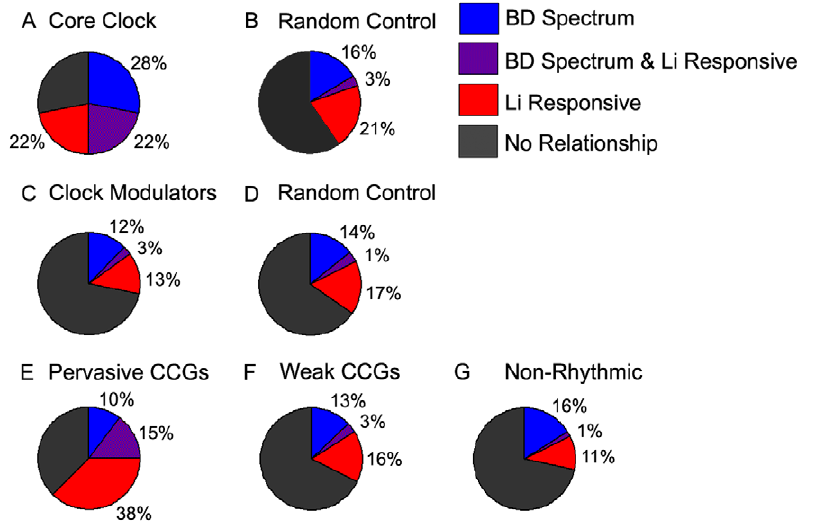
Figure 3. Overlap among clock genes, genes associated with BD spectrum illnesses by GWAS, and lithium-responsive genes. For each set of genes, the % associated with BD spectrum illnesses by GWAS (blue), the % found to be lithium-responsive (red), and the overlap between these (purple) is shown for 18 core clock genes (A), 342 clock modulator genes (C) and 136 pervasively rhythmic clock controlled genes (CCGs) (E) compared to their respective randomly selected controls (B and D), CCGs that are less pervasively rhythmic (F), and genes with no evidence for rhythmicity (G). Gray indicates % of genes with no relationship to either BD or lithium response.